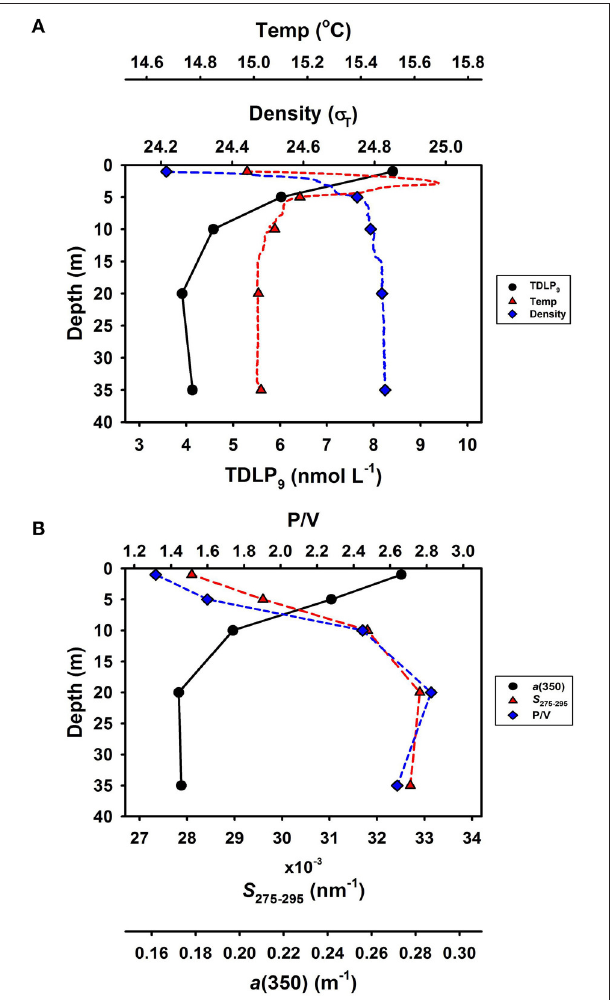
FIGURE 5 | Vertical profiles of (A) lignin phenol concentrations (TDLP 9 ), temperature and density ( σ T ), (B) CDOM absorption coefficient a (350), spectral slope S 275 – 295 and lignin composition P/V at station L3 in November 2013. Temperature and density data are form conductivity-temperature-depth (CTD) sensors at each 0.1